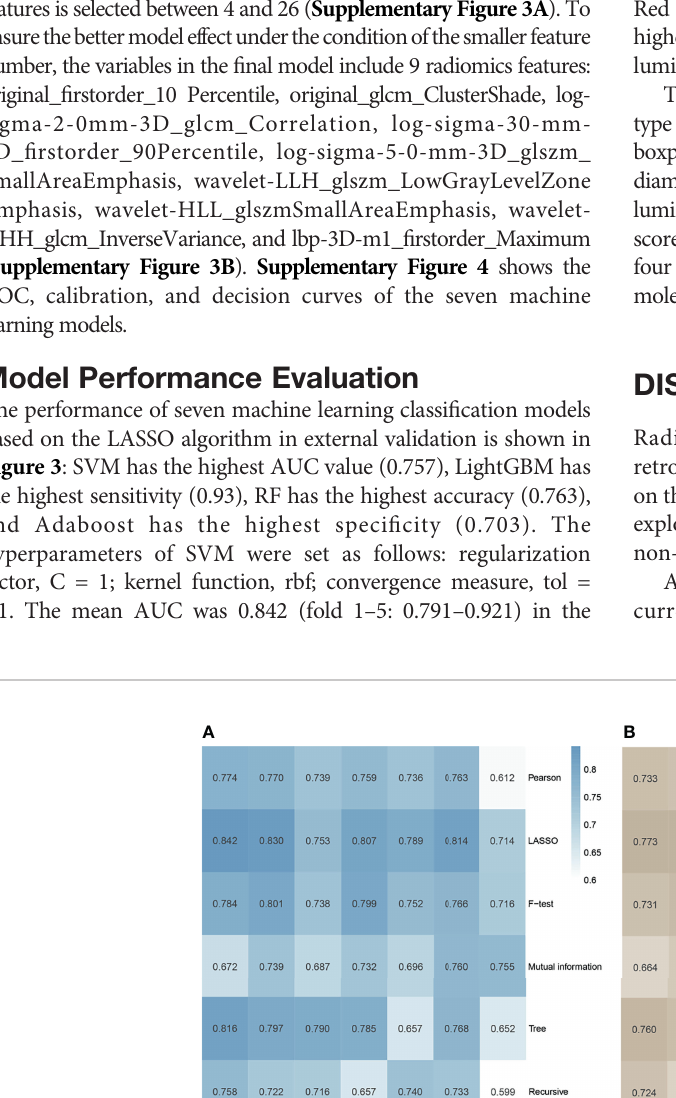
Figure 4B : with the increase of training samples, the performance of the model in internal validation tended to be stable. The AUC of the fi nal model in the test set was 0.757, 95% CI: 0.640 – 0.866 ( Figure 4C ); and the calibration curve showed a good fi tting effect ( Figure 4D , Brier score = 0.103). The model evaluation indexes of the training set and test set are shown in Table 2 . Figure 5 is the SHAP plot of the visualization for the prediction model, which described the relationship between the high and low features ’ SHAP values of the training set. According to the LASSO_SVM model, a dot is created for each feature value of the model for each patient, so a dot is assigned to each patient on each feature line. The dots were colored according to the feature values of their respective patients and vertically accumulated to depict density.